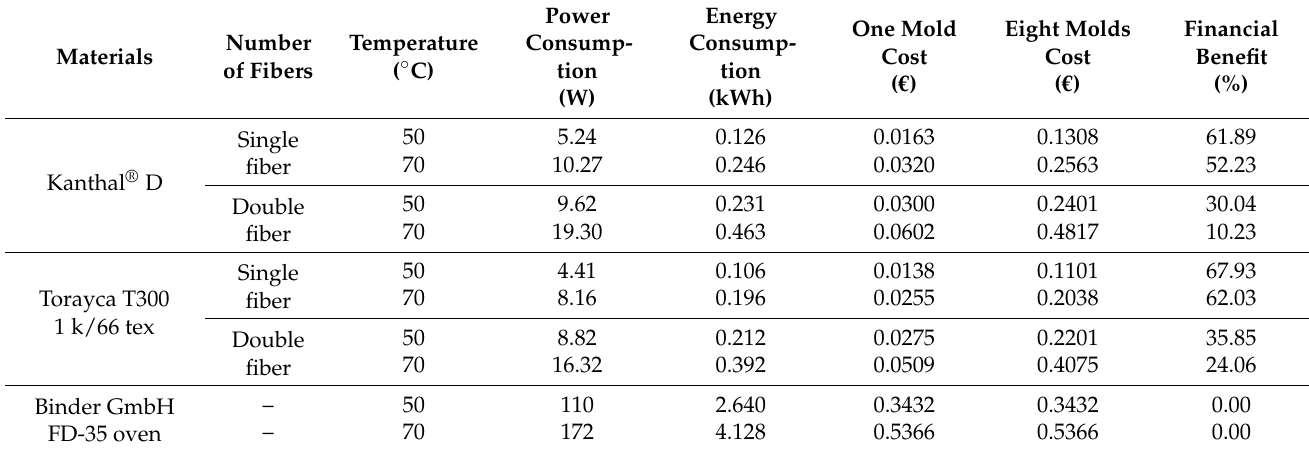
Table 5. Cost of curing and financial